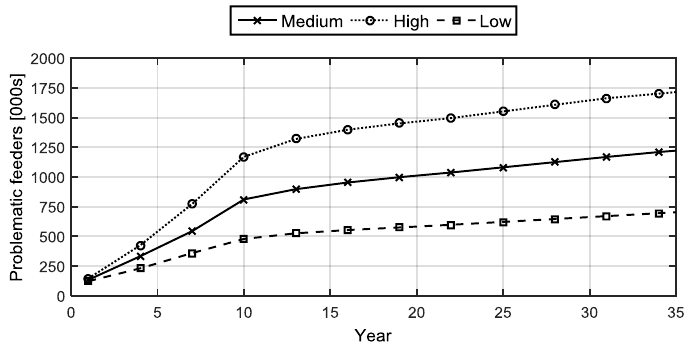
Figure 4 . Number of problematic feeders under different PV growth scenarios. Figure 4. Number of problematic feeders under different PV growth